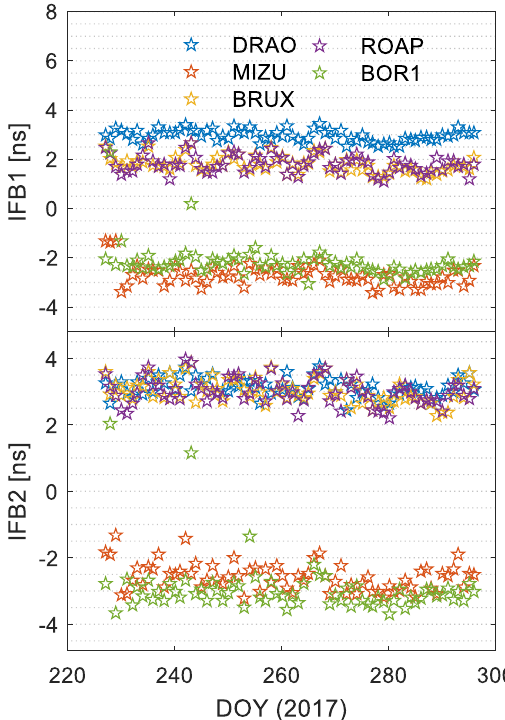
Figure 2. IFCB series of five stations for satellite R02: ( Top ) is the IFCB1 series, and ( Bottom ) is the IFCB2 series.